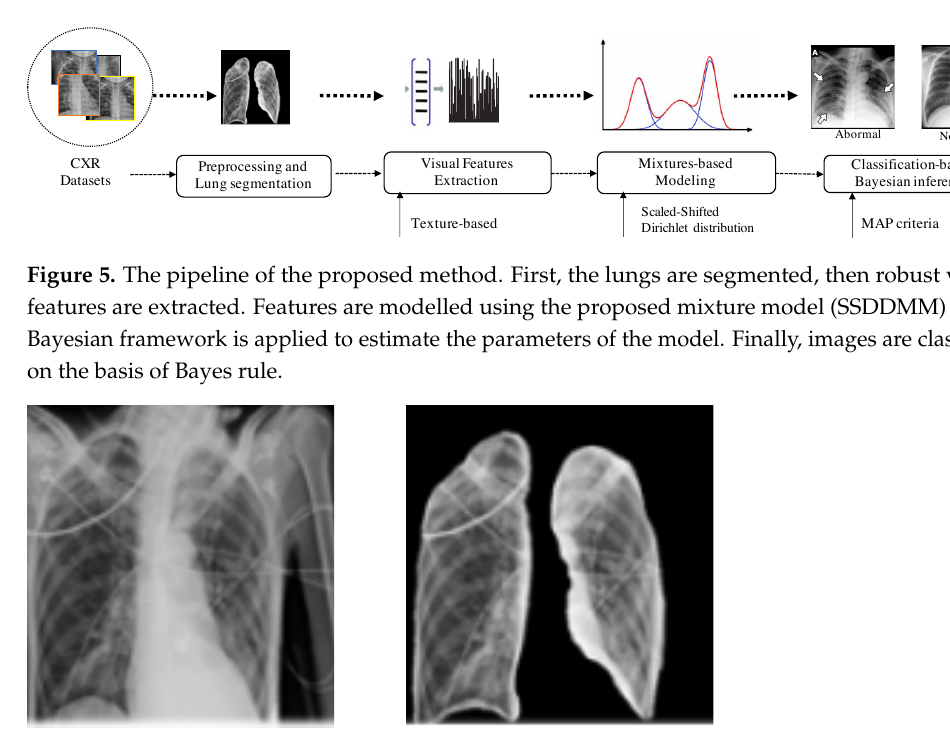
Figure 6. Process of lungs regions extraction applied on image sample from